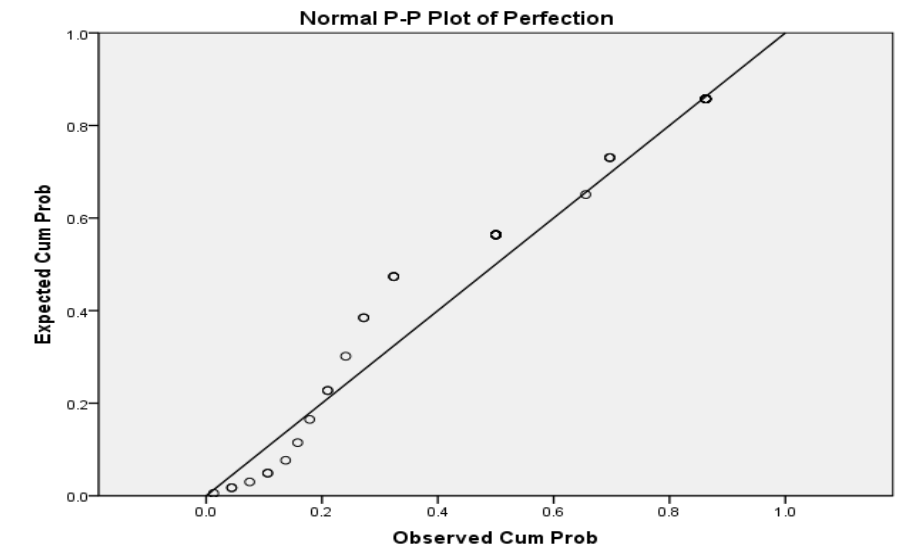
Figure 6. Lean Principles “Perfection” against ISO 14001